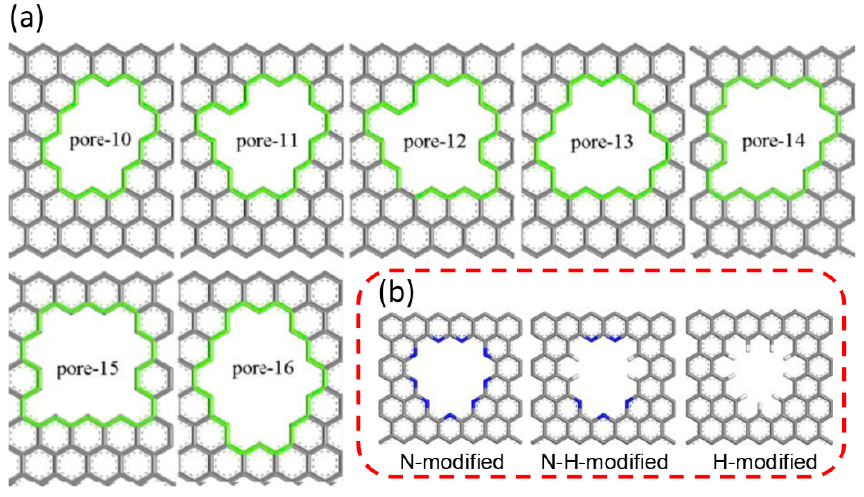
Figure 5. ( a ) Structure of porous graphene models. ( b ) Structure of the modified pore-13